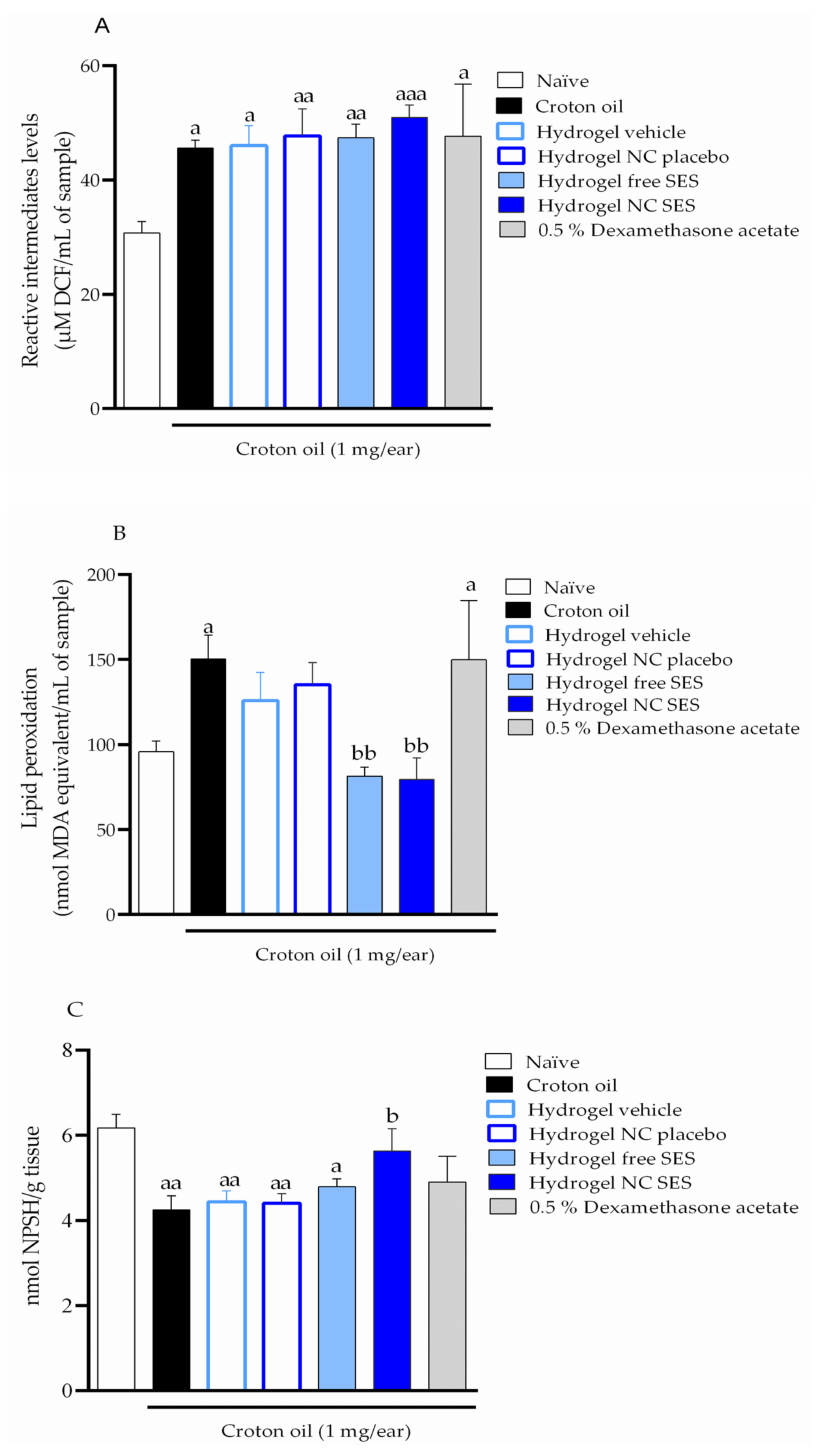
Figure 13. Effect of the hydrogels containing free or nanoencapsulated sesamol topically applied (15 mg/ear) in the mice’s ear on the ROS ( A ), lipid peroxidation ( B ) and nonprotein thiols levels ( C ) in the croton-oil-induced ear edema model in Swiss mice. The topical treatments were applied in the mice’s ear immediately after the croton oil. The ear tissue for the assay was collected 6 h after the croton oil or croton oil plus treatments. Each bar represents the mean ± SEM ( n = 7); aaa p < 0.001, aa p < 0.01 and a p < 0.05 show a significant difference when compared to the naive group; b p < 0.05 and bb p < 0.01 indicate a significant difference when compared to the croton oil control group; one-way ANOVA followed by post hoc Tukey’s